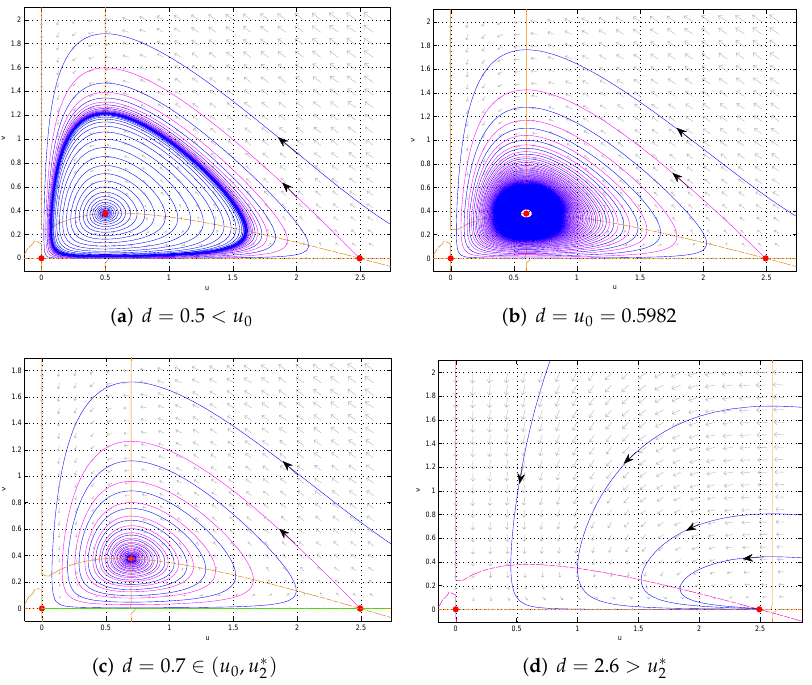
Figure 4. The dynamics of model (2) in the case of weak Allee effect as d = 2 ( a = 0.8, r = 1 ) . u m = 1.5, α = 1, a r